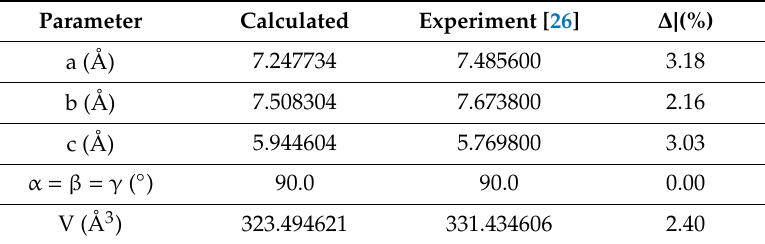
Table 2. Calculated and experimental structural parameters of Al 2 SiO 5 .